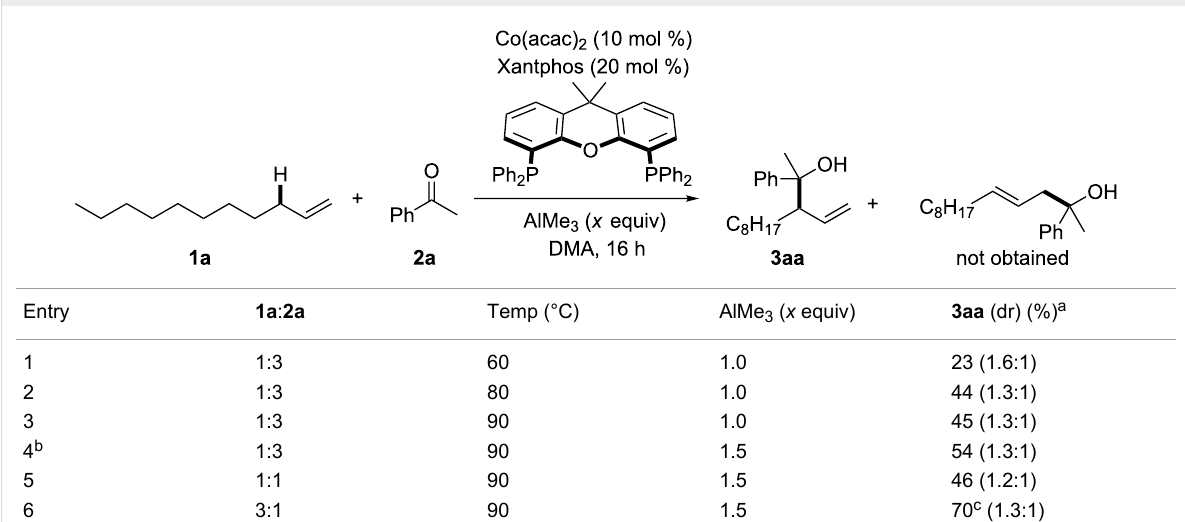
Table 1: Screening of reaction conditions.